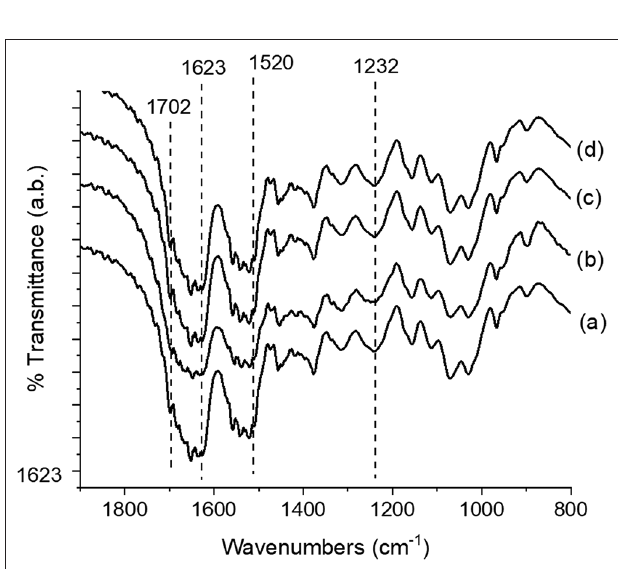
FIGURE 2 | FTIR spectra of the Antheraea pernyi silk fibroin/chitin-based structures; (a) APC80B, (b) APC20C, (c) APC20B, and (d) APC80C.